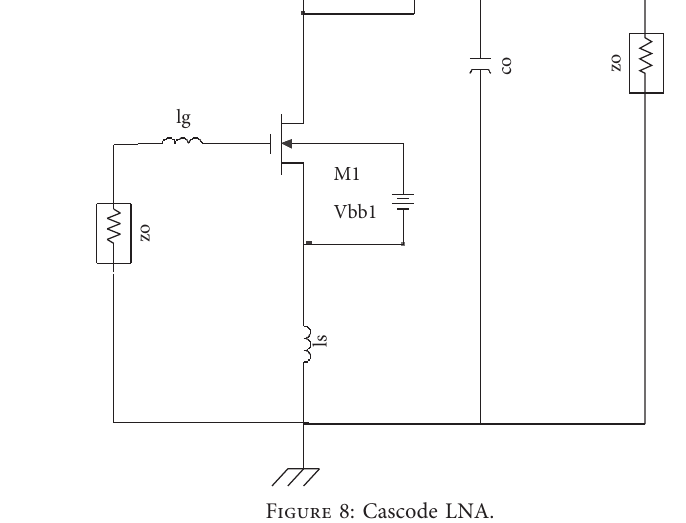
Figure 8: Cascode